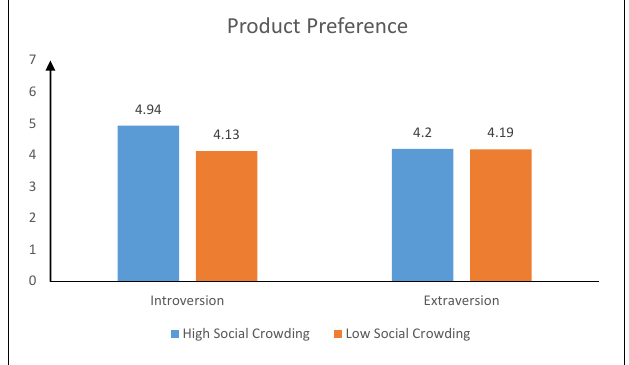
FIGURE 7 | The moderating effect of personality trait.